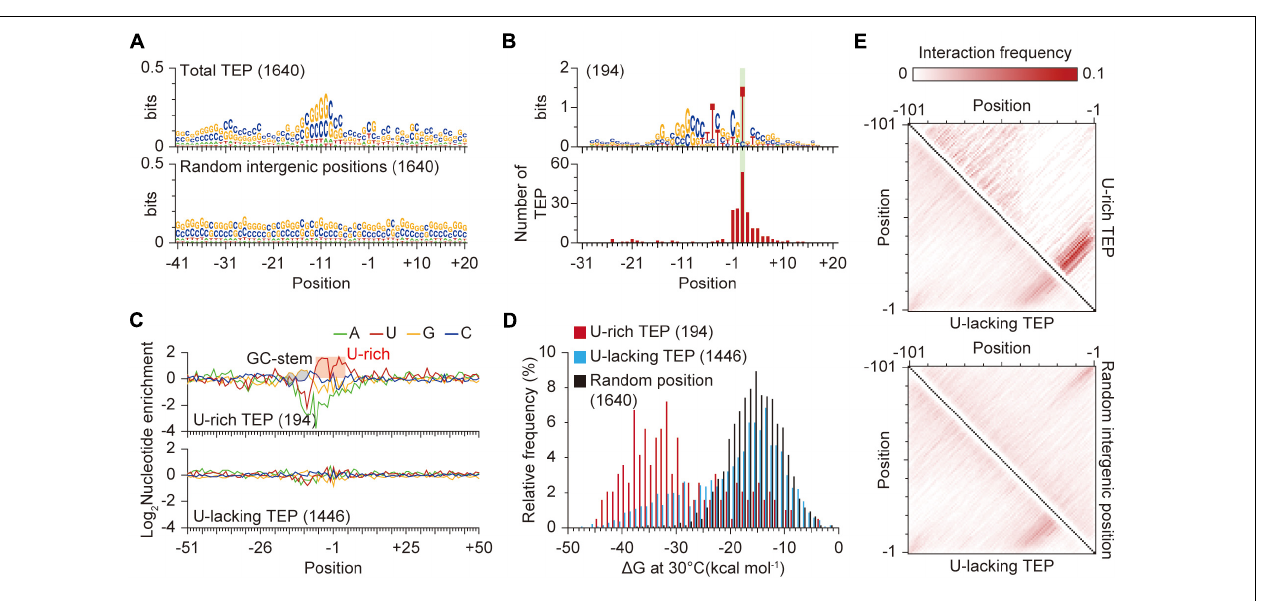
( Figure 5D ). Surprisingly, the (cid:49) G values of U-rich TEPs